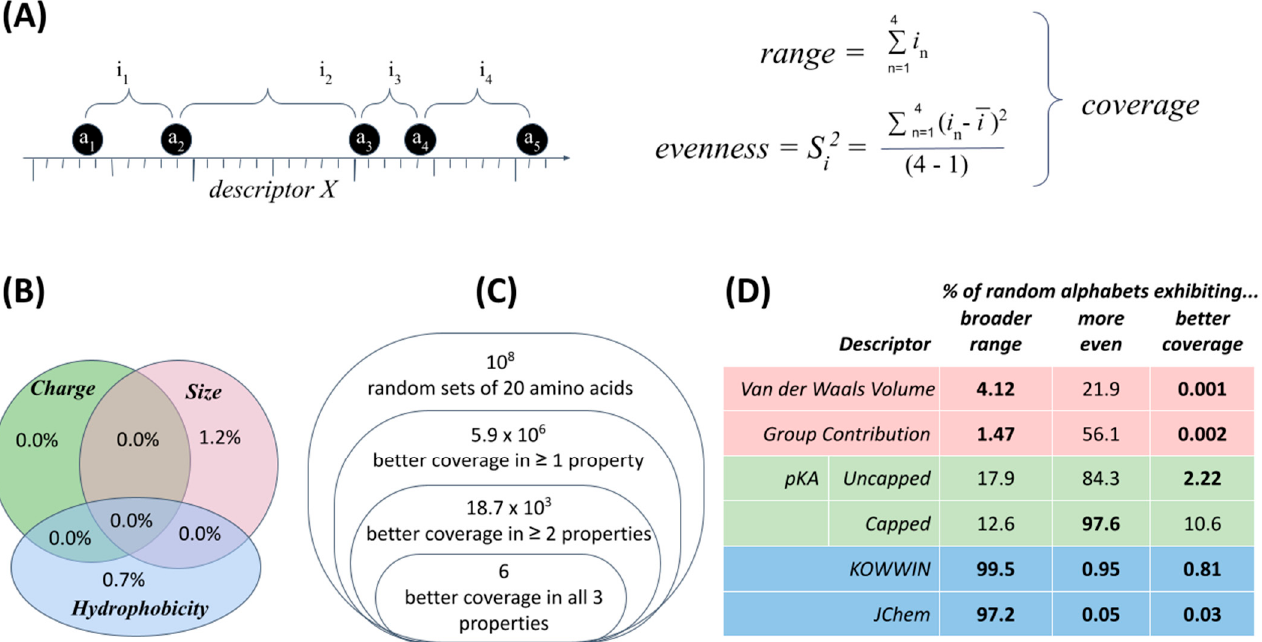
Figure 4. Unusual properties of the standard amino acid alphabet. ( A ) For a given chemical descriptor such as van der Waals volume, “coverage” combines two statistics to represent a set of amino acids. ( A ) Illustrates these statistics for a set of five amino acids (a 1 . . . a 5 ) with four corresponding intervals (i 1 . . . i 4 ) measured in terms of the hypothetical quantitative descriptor x . Evenness is the sample variance (S 2 ) of intervals between neighboring amino acids; “Range” is the sum of these intervals ( ∑ i 1 ... 4 ); ( B ) Percentage of random amino acid alphabets drawn from a pool of 76 plausible alternatives that are more evenly distributed over a larger range than the standard alphabet, data from [38]; ( C ) Number of randomized amino acid alphabets within a sample of 10 million which are more evenly distributed over a broader range of values for one, two and all three of these properties, data from [39]; ( D ) the relative contribution of range versus evenness for variations in each descriptor, adapted from [40], with all significant values (<5%) shown in bold